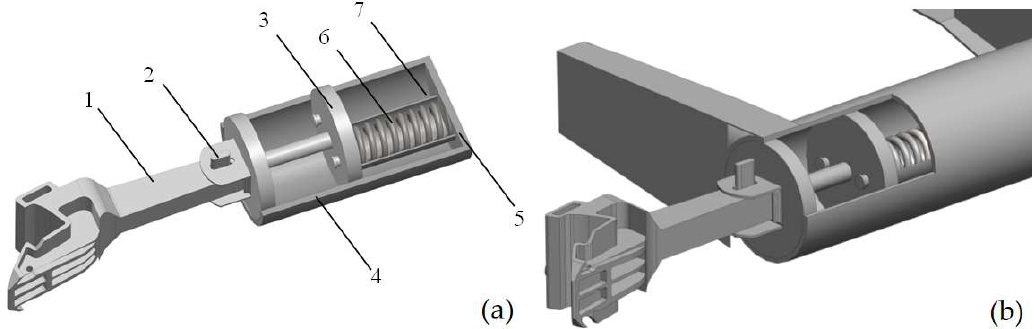
Figure 2. Draft gear concept for the automatic coupler: ( a ) concept components; ( b ) location on wagon frame. 1, automatic coupler frame; 2, wedge; 3, adapter; 4, circular-tube center sill; 5, bottom; 6, spring; 7, telescopic element.